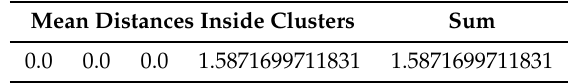
Table 2. The sum of the mean distances inside the clusters.